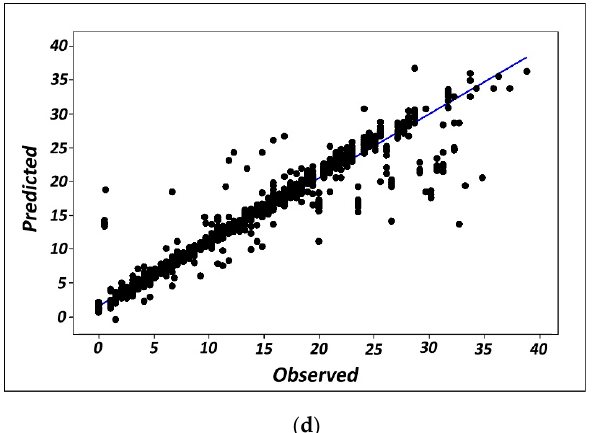
Figure 9. The RST-LSTM ( a , b ) and IT2F-LSTM ( c , d ) scatter plots display the positive linear relation between the observed time series and the predicted value during the periods of training ( a , c ) and testing ( b , d ).